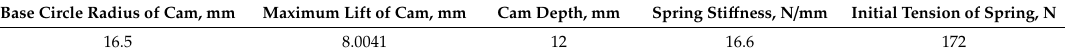
Table 1. Key parameters of the cam / tappet